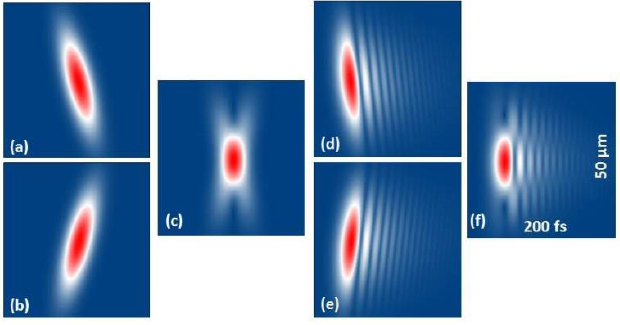
Fig. 2. Field distribution of single and dual channel configuration in the focal region simulated for a Gaussian pulse (center wavelength 619 nm, FWHM bandwidth 40 nm, initial FWHM pulse duration 14.2 fs, GDD = 9600 fs2); perfect compensation: (a), (b) left and right arm, (c) superposition of both; with realistic chirp: (d), (e), (f), respectively (normalized). The grating orientation determines the direction of pulse front tilt. Therefore, the superposition creates a cross-shaped field (see